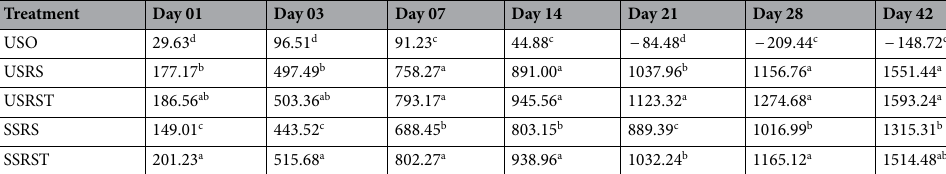
Table 2. Effect of Soil Sterility and Trichoderma Inoculation on the Cumulative CO 2 evolved (mg CO 2 ) from the decomposing rice straw for each sampling period. *Means with the same letter are not significantly different ( p < 0.05). USO = unsterile soil only; USRS = unsterile soil plus rice straw; USRST = unsterile soil plus rice straw plus Trichoderma ; SSRS = sterile soil plus rice straw; SSRST = sterile soil plus rice straw plus